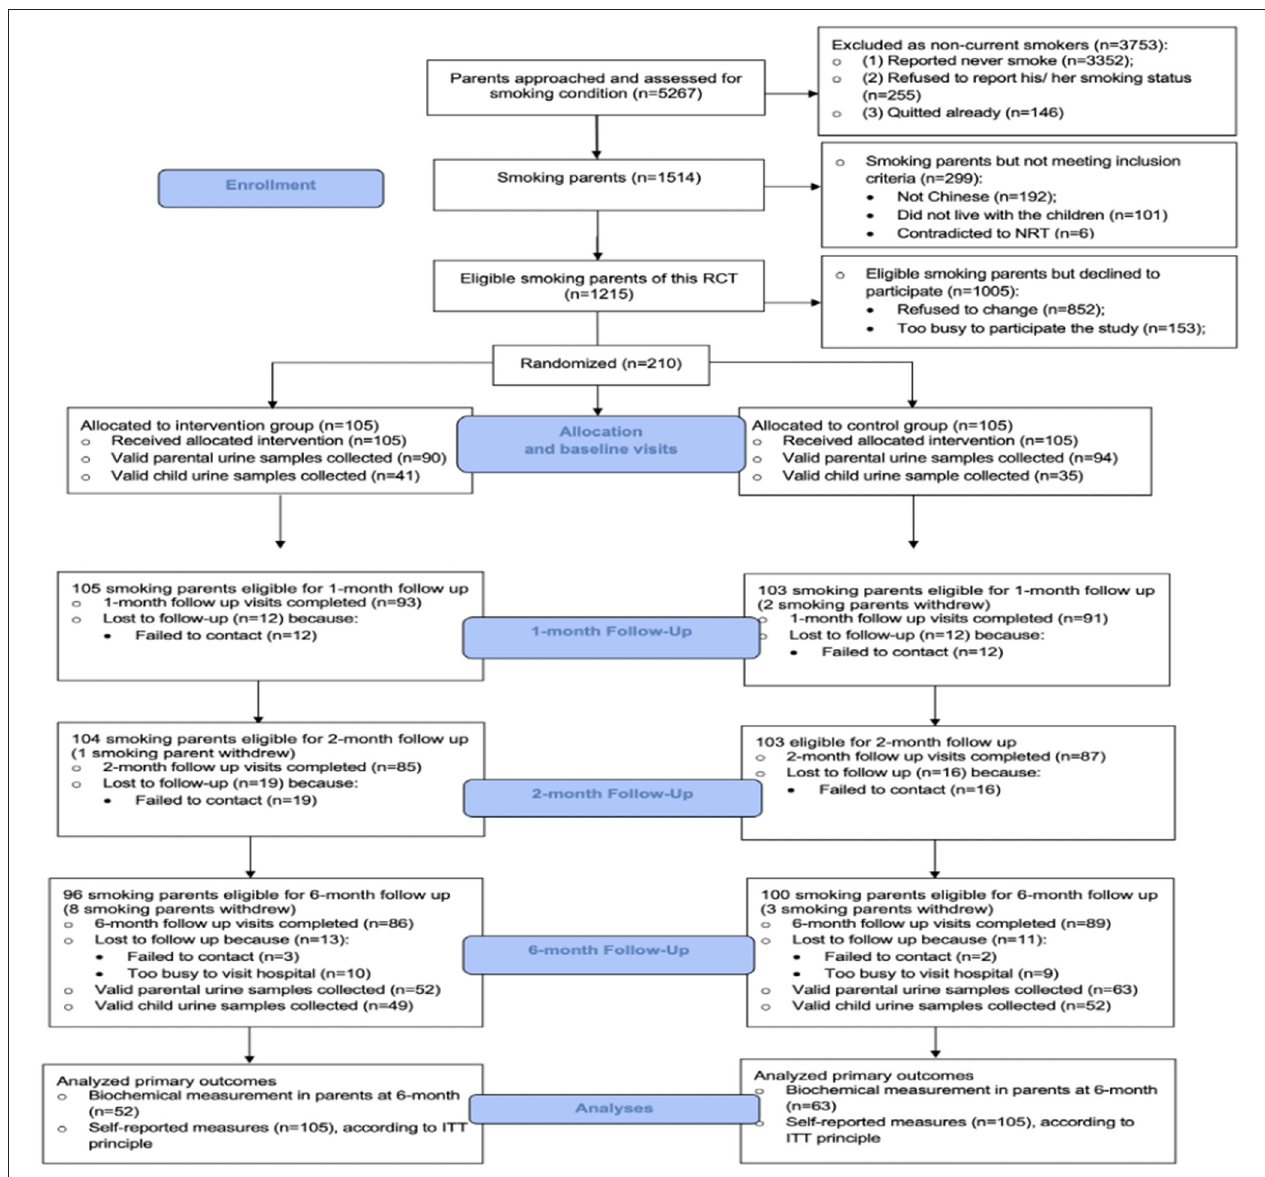
FIGURE 2 | The CONSORT flow